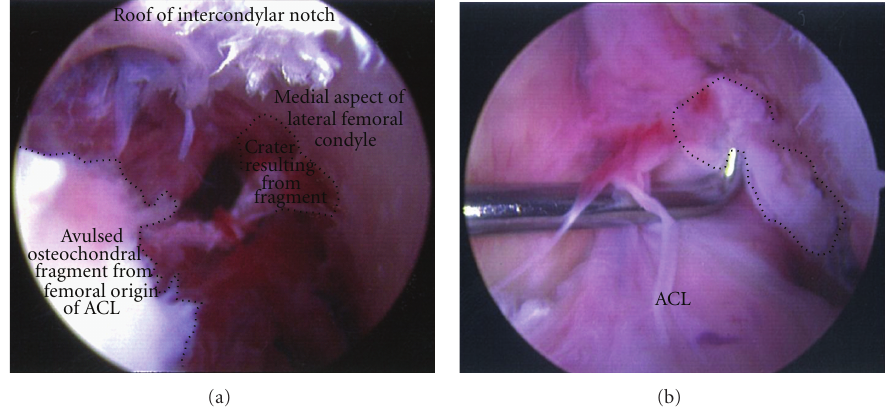
Figure 2: Intraoperative arthroscopic images depicting (a) an empty lateral wall of the intercondylar notch resulting from an osteochondral avulsion fracture of the femoral end of the ACL and (b) an arthroscopic hook reducing the fragment (outlined by black dots) to its normal